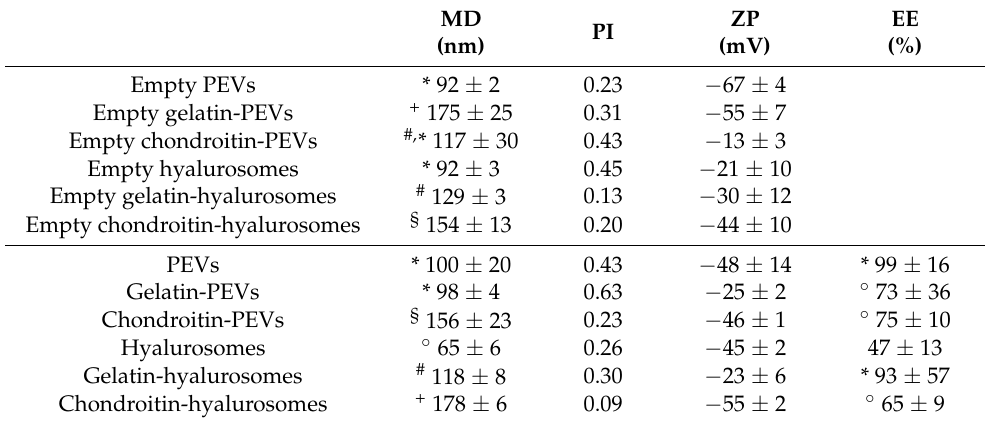
Table 1. Mean diameter (MD), polydispersity index (PI), zeta potential (ZP) and entrapment efficiency (EE) of empty and extract-loaded PEVs, gelatin-PEVs, chondroitin-PEVs, hyalurosomes, gelatin- hyalurosomes, chondroitin-hyalurosomes. Data represent the mean ± standard deviation of at least six replicates. The same symbol (*, § , + , # , ◦ ) indicates the same value ( p < 0.05). MD (nm)